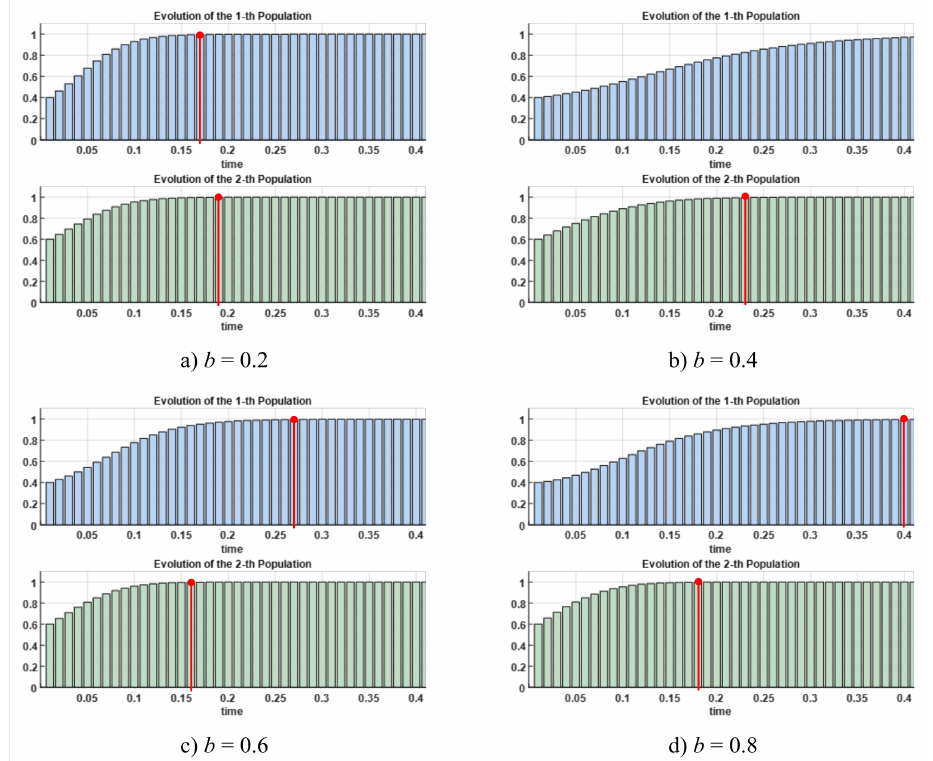
Figure 11. Influence of b change on system evolution (under government supervision).